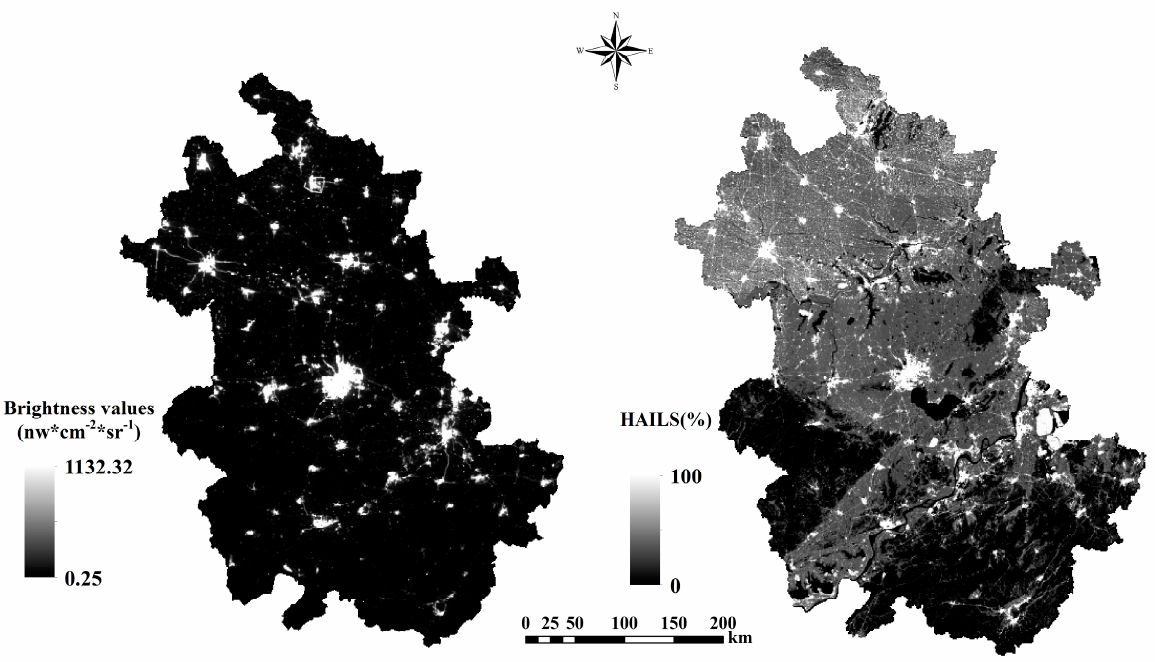
Figure 9. Nighttime light data ( left ) and HAILS ( right ) of Anhui Province in 2020.